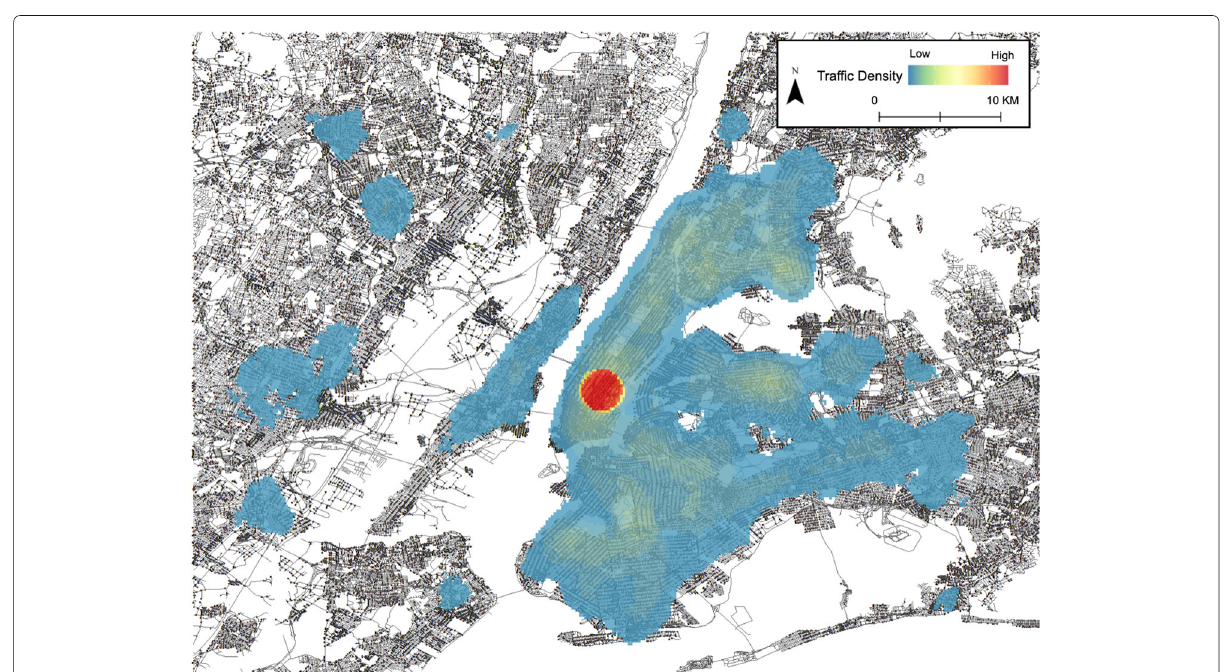
Fig. 11 Traffic Density During Morning Commute